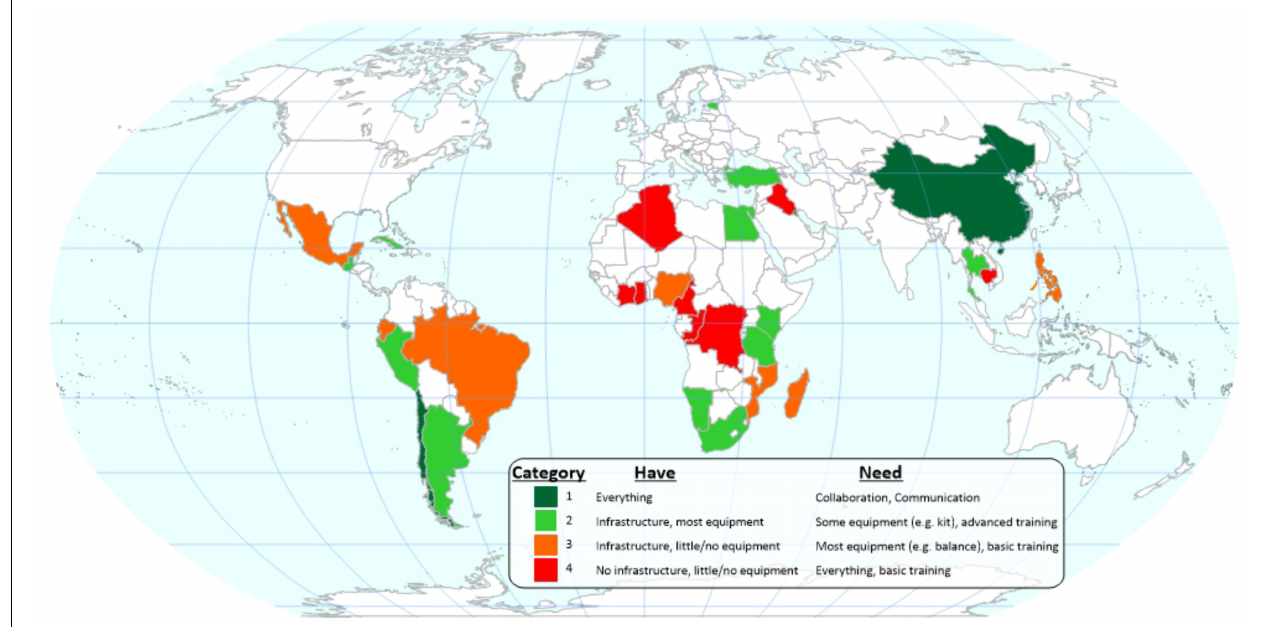
FIGURE 8 | Results from a gap analysis survey of in-country researchers by the IAEA, TOF, IOC-UNESCO, NOAA and others in 2016 to assess the status of a developing country’s ability to monitor OA or track its effect on relevant marine